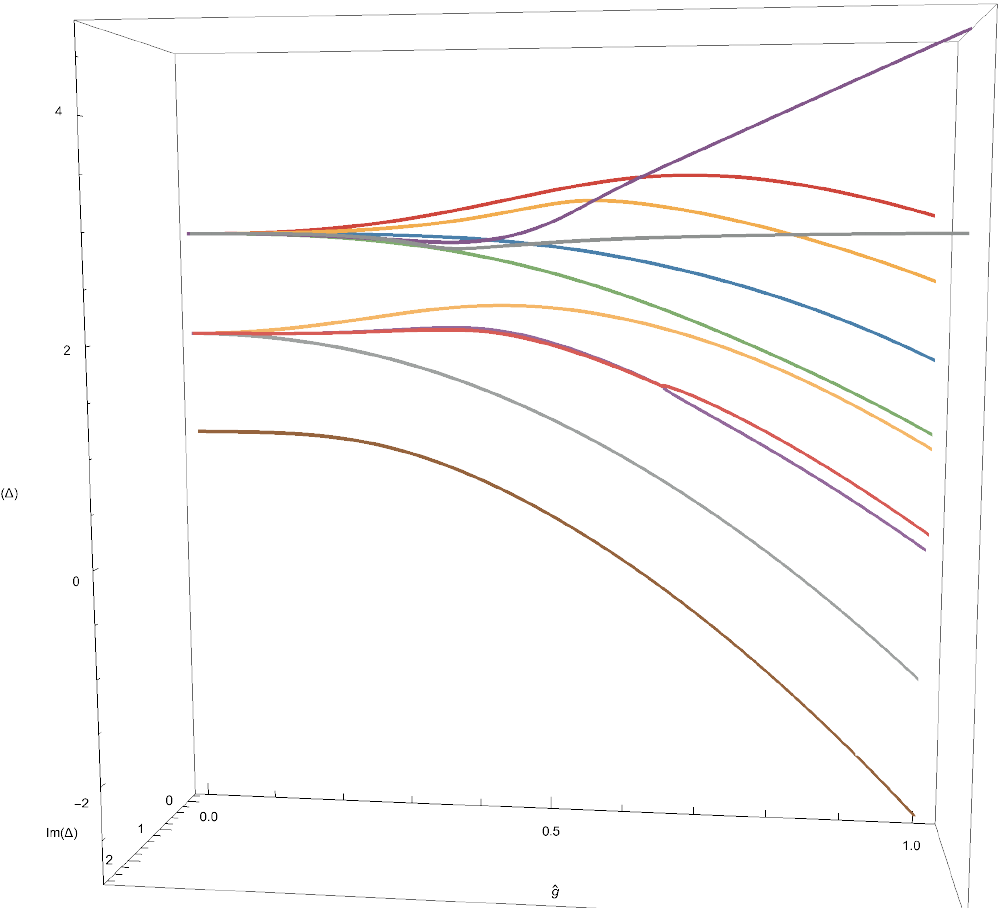
Figure 13. Numerical spectrum with excited states for J = 1 and S = 0 . The lowest curve (starting at ∆ = 1 at zero coupling) corresponds to the case with a single insertion of Z at the cusp. The curves which begin at higher integers at zero coupling correspond to excited states of the solution of the Baxter equation, which correspond to additional insertions of Φ cusp (see [19] for some explicit examples). Whereas for the ground state the dimension ∆ is real, excited states could appear in complex conjugate